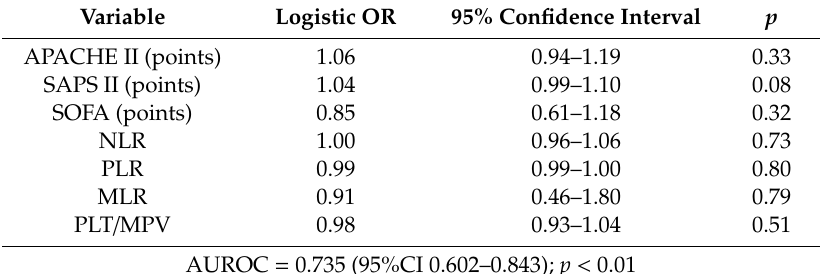
Table 7. Mortality prediction in patients with septic shock in multivariate analysis. Variable Logistic